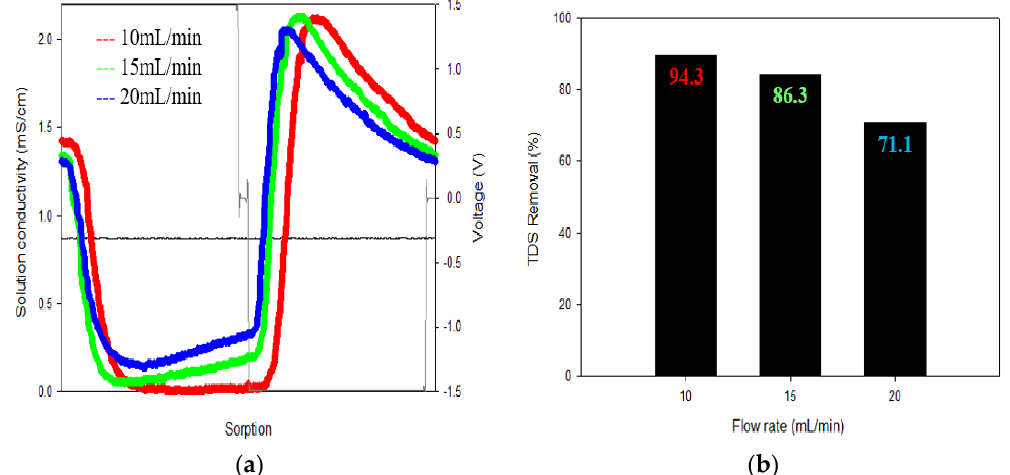
Figure 5. The results of the flow rate of the CDI: ( a ) Flow rate was set in 5 mL/min increments from 10 mL/min to 20 mL/min; ( b ) The TDS removal rate was the highest at 94.3% at 10 mL/min.